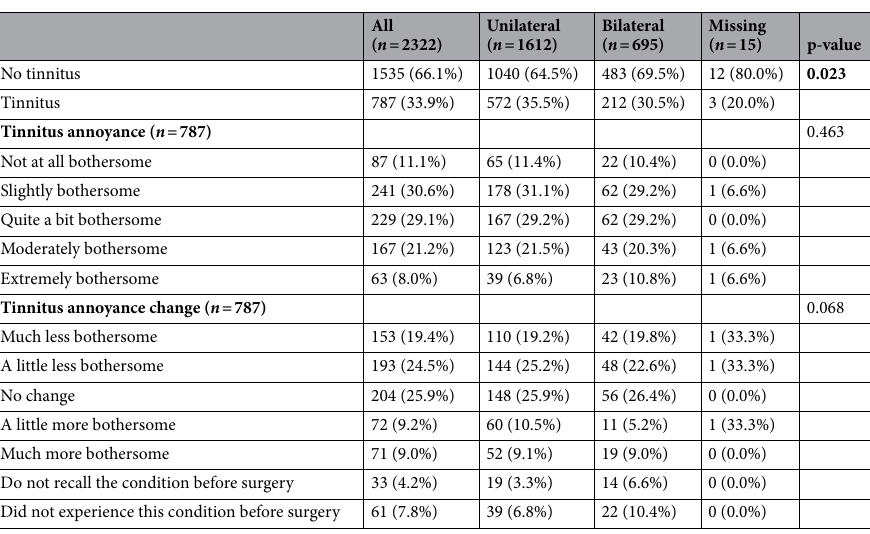
Table 2. Number (%) of subjects reporting tinnitus characteristics by unilateral versus bilateral implants. p-values are from chi-squared tests comparing unilateral and bilateral (i.e. missing category excluded). Bold indicates statistically significant p < 0.05.